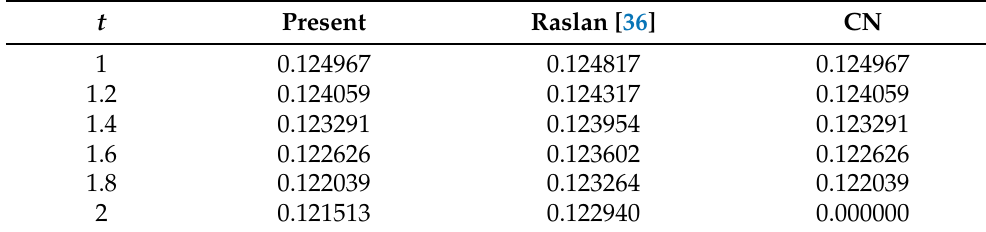
Table 3. Invariant at N = NT = 50, T f = 2.